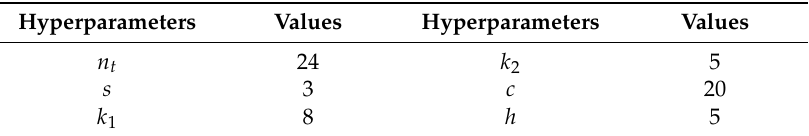
Table 5. Hyperparameters of the virtual sensor model for response prediction of the cantilever plate finite element model.